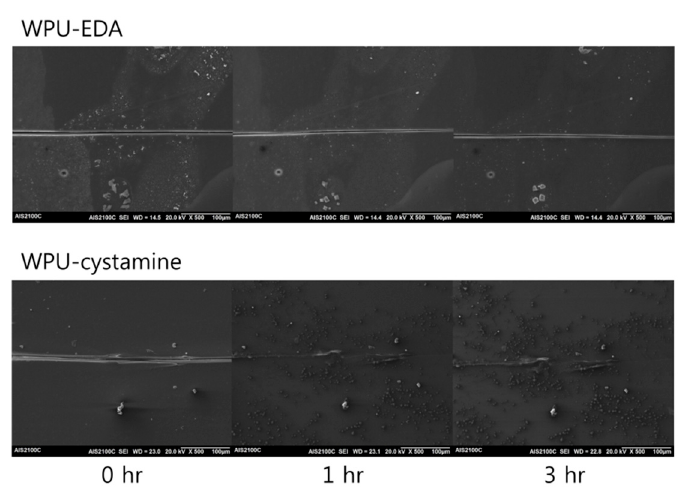
Figure 5. Scratch healing tests of WPU-EDA and WPU-cystamine at 110 ° С .